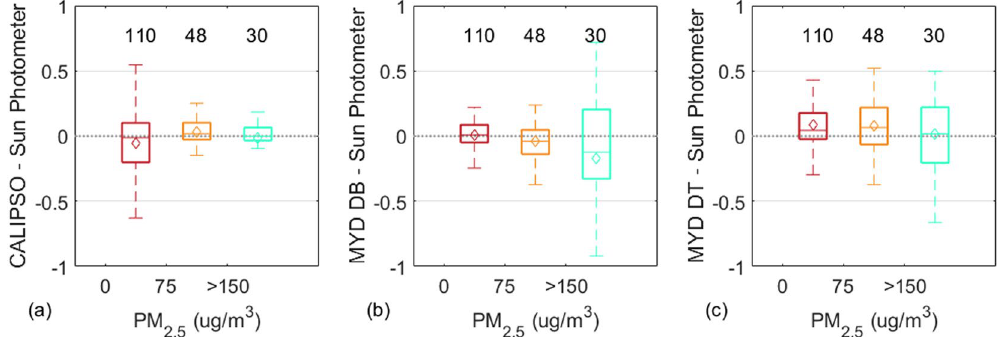
Figure 3. Box plots of AOD differences between ( a ) CALIPSO and sun photometer; ( b ) MODIS-DB and sun photometer; and ( c ) MODIS-DT and sun photometer with PM2.5 concentration change over Central China. The numbers represent the sample size of each box. The middle line and square show the median and mean value of the AOD differences, respectively.